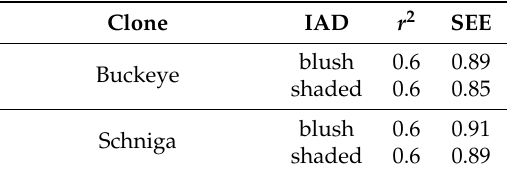
Table A8. Summary of linear regression for predicting FFF based on IAD measurements for season 2017. The regression was significant at p >